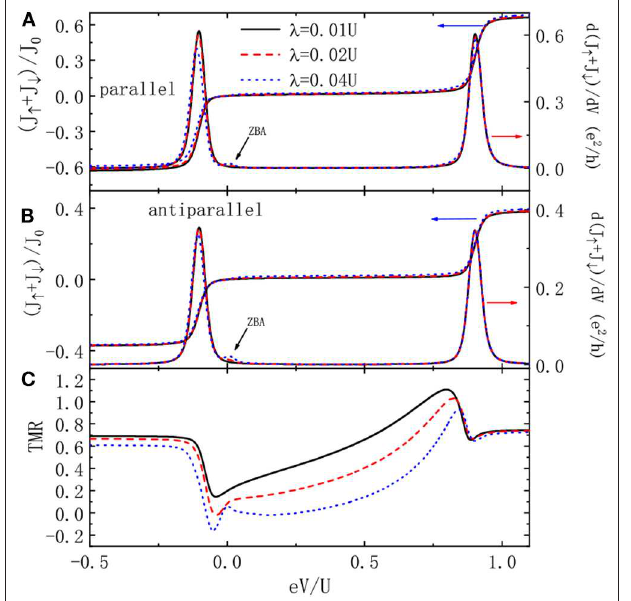
FIGURE 3 | Total current, non-linear differential conductance for the magnetic moments’ configurations of parallel (A) and antiparallel (B) , and the corresponding TMR (C) . Other parameters are as in Figure 2 .